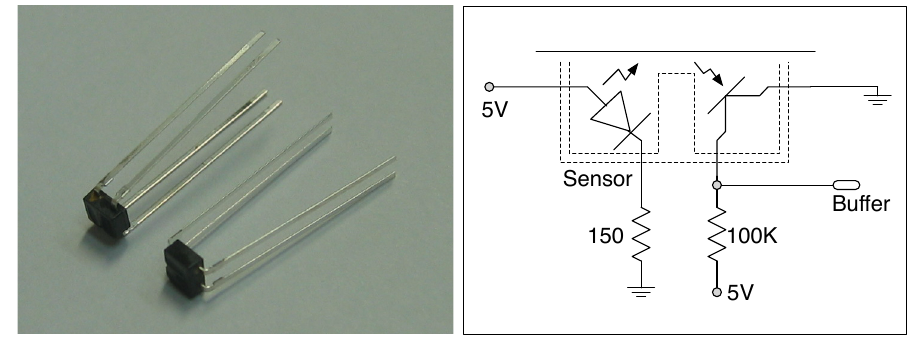
Figure 4. Reflective photo interrupters ( left ) and electric circuit ( right ).